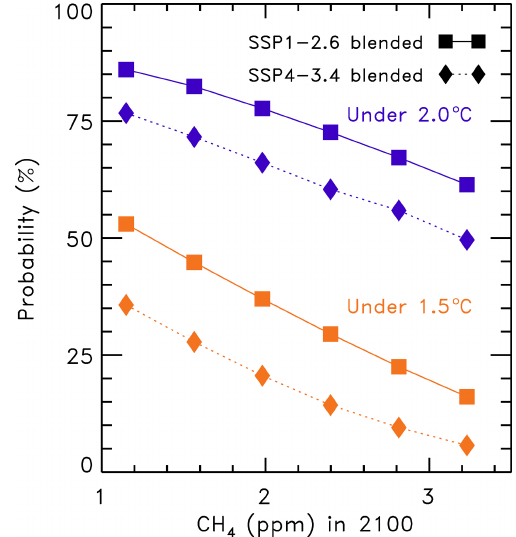
Figure 13. Probability of staying at or below the Paris Agreement target and upper limit for SSP1-2.6 and SSP4-3.4 as a function of varying methane scenarios using the EM-GC trained with the Had- CRUT5 (cid:49)T record. The atmospheric methane scenarios are calcu- lated using linear combinations of methane abundances from SSP1- 2.6 and SSP3-7.0 to span the range of future methane